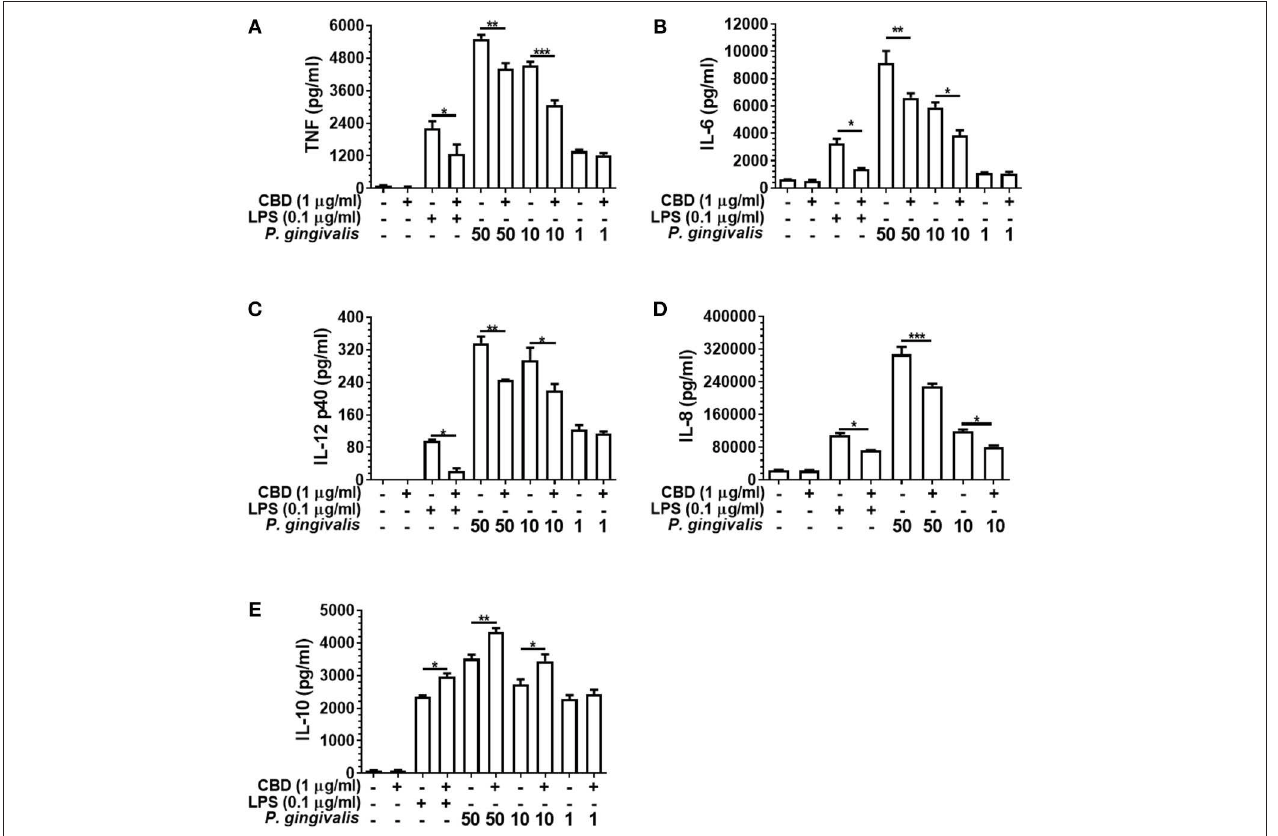
FIGURE 3 | Phytocannabinoids alter the monocytic cytokine release profile in response to oral bacteria. Control and CBD (2h) pre-exposed monocytes were stimulated, or not, with LPS or P. gingivalis and cytokine [ (A) TNF, (B) IL-6, (C) IL-12 p40, (D) IL-8, (E) IL-10] release measured in 20h cell-free supernatants by ELISA. Similar data was found upon F. alocis and T. denticola stimulation ( data not shown ). Similar phenomenon were also apparent with two the other phytocannabinoids tested, CBN and THC ( data not shown ). Data represent the mean ± SD of three biological replicates with paired data-points analyzed by t -test. * / ** / *** p ≤